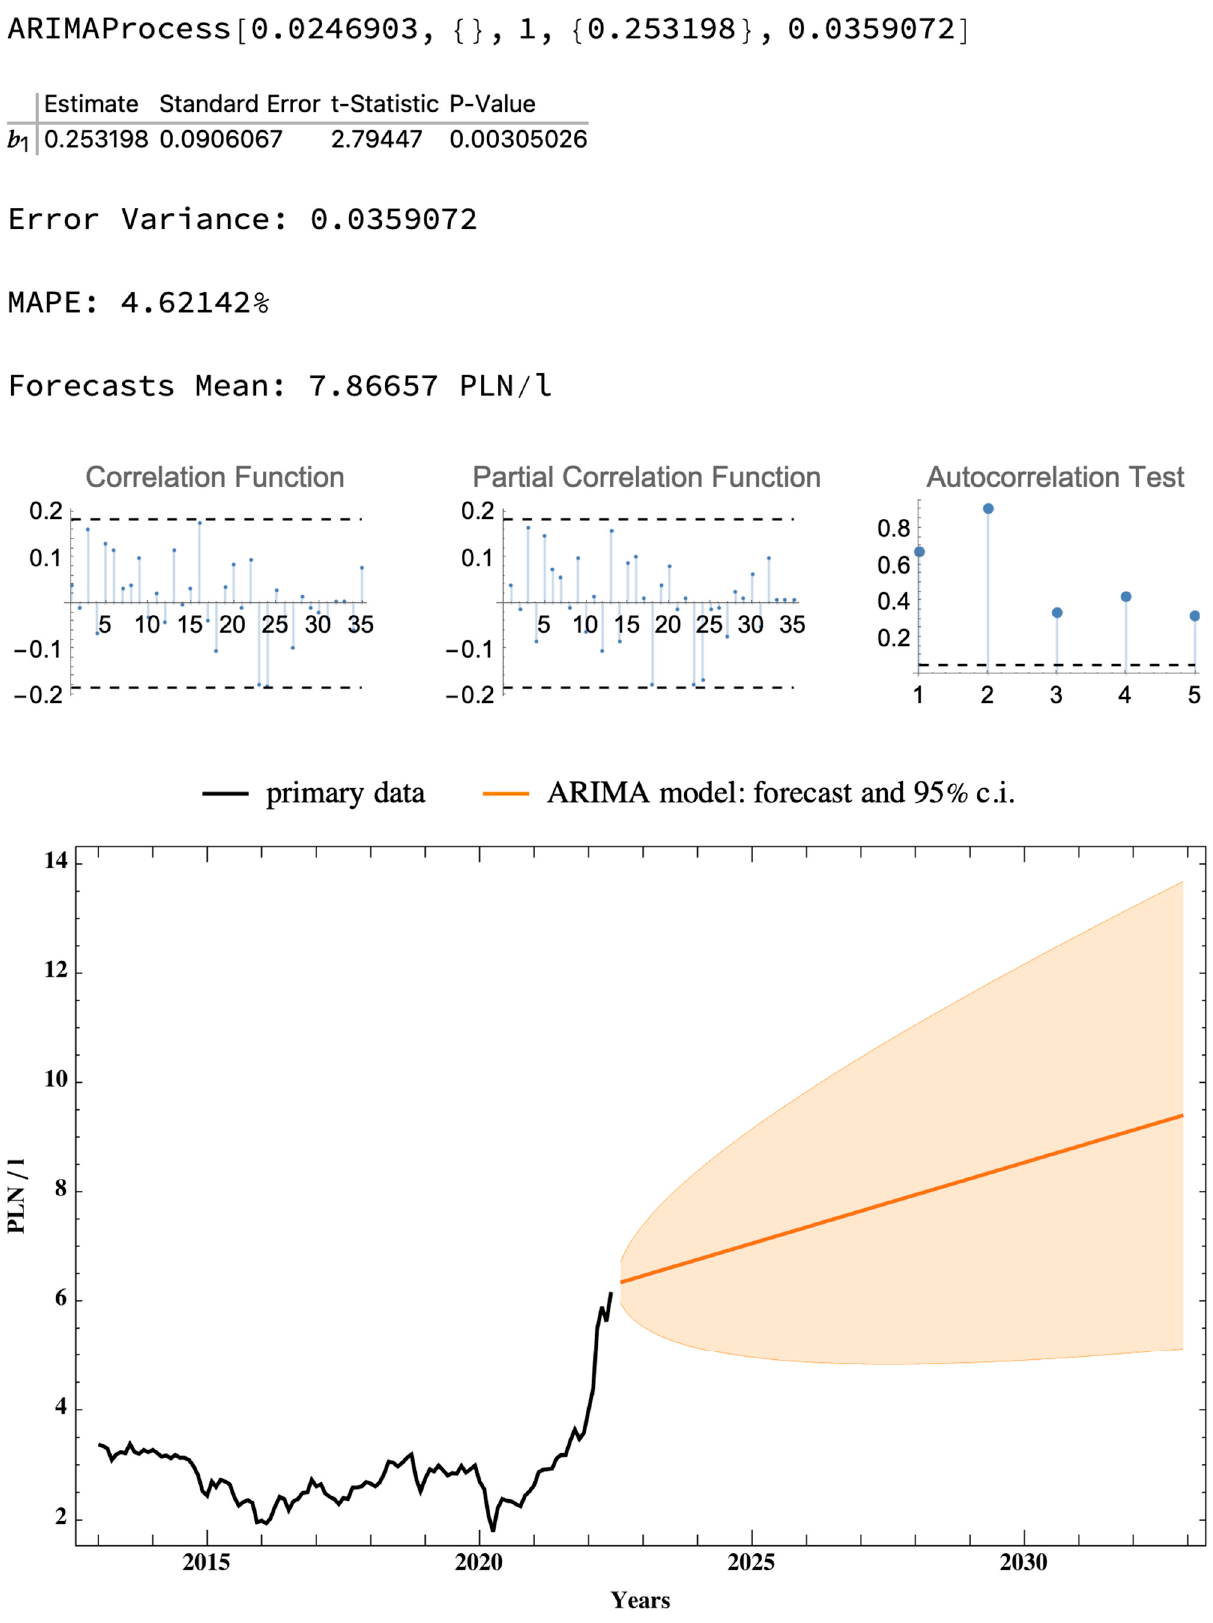
Figure 3. Results of the SARIMA model forecasting Ekoterm heating oil prices.